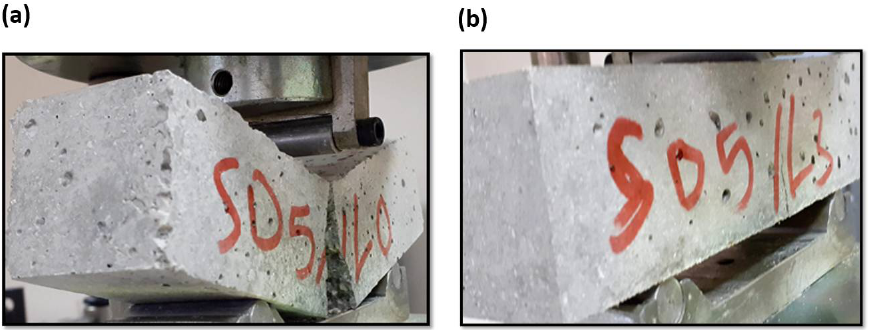
Figure 12. Failure behavior of (a) non-fiber-reinforced sample and (b) 15% fiber reinforced sample .